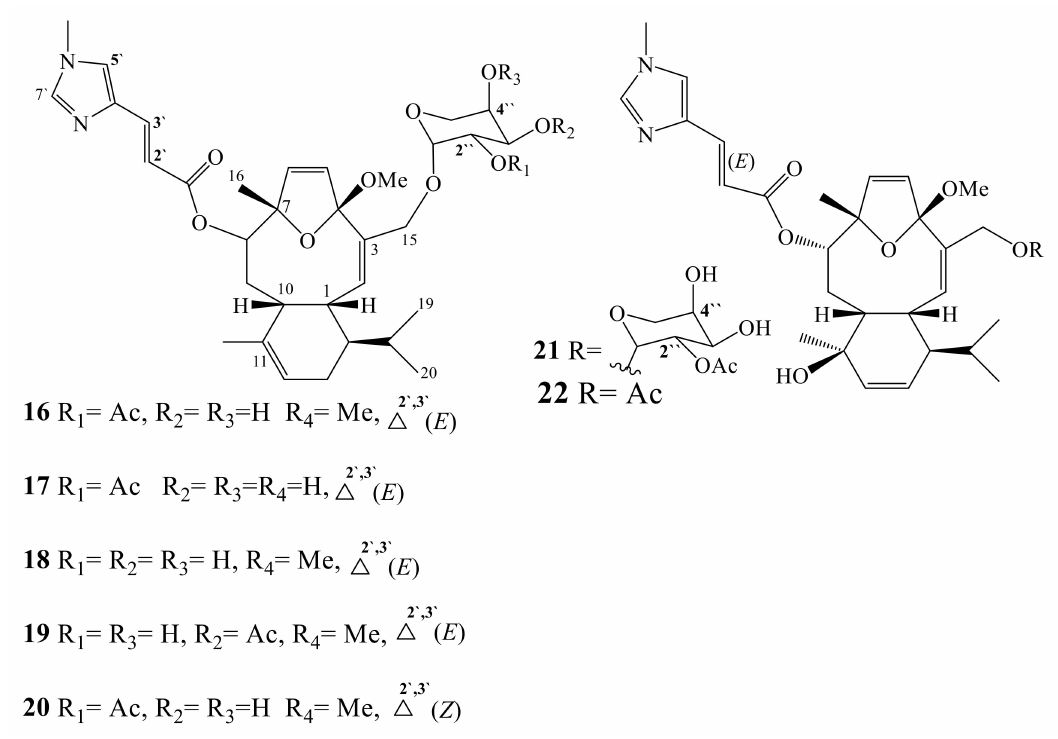
Figure 2. N-Containing diterpenes ( 16 – 22